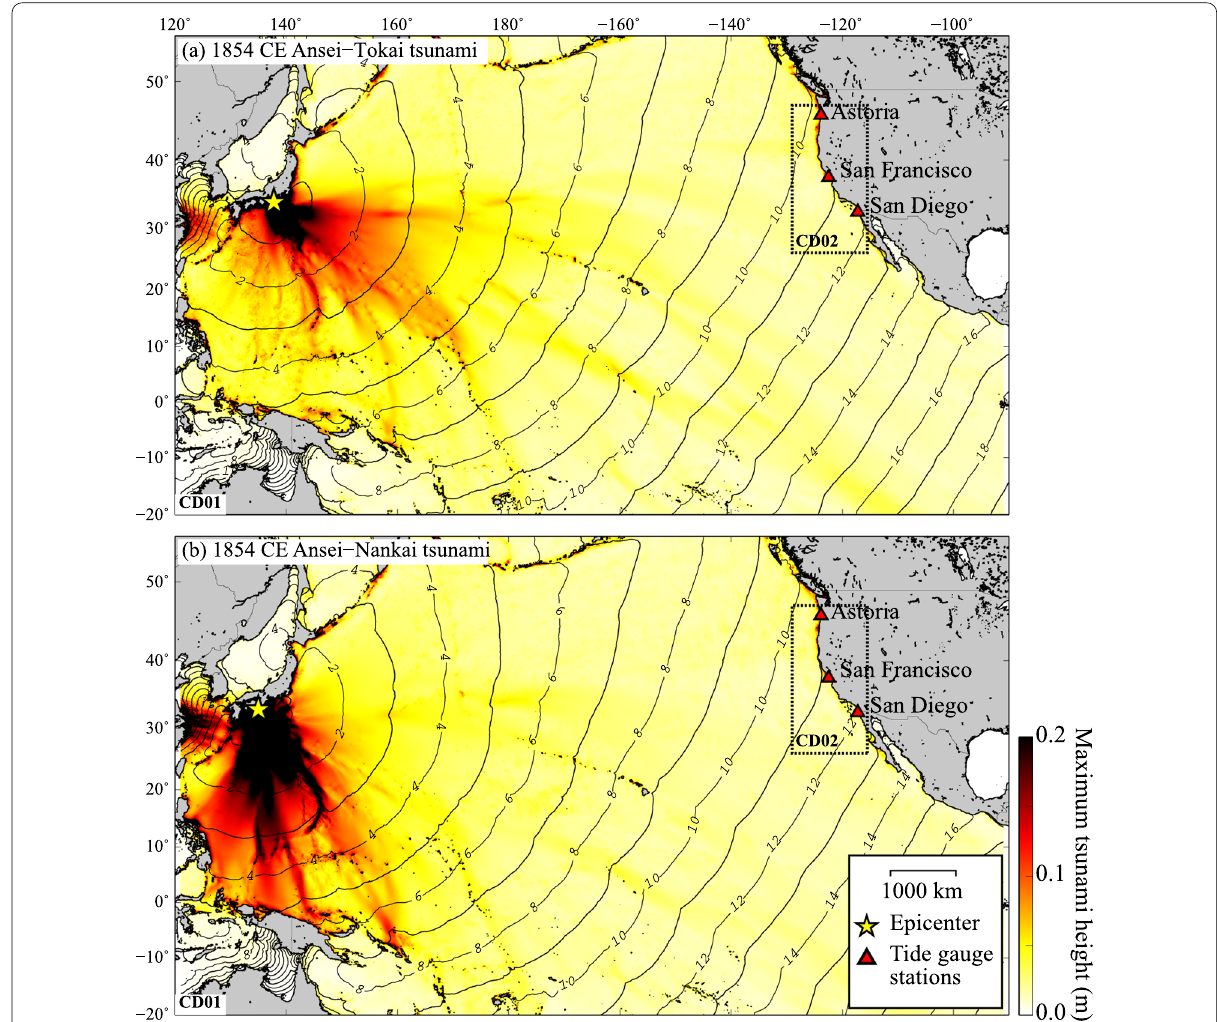
Fig. 1 Distributions of maximum tsunami heights and tsunami travel times of the 1854 CE a Ansei–Tokai and b Ansei–Nankai earthquakes. CD01 and CD02 are the computational domains of 54 and 18 s in grid intervals, respectively. The contour interval is 1 h. The earthquake epicenters are shown by yellow stars, and the locations of the North American tide gauge stations are shown by red